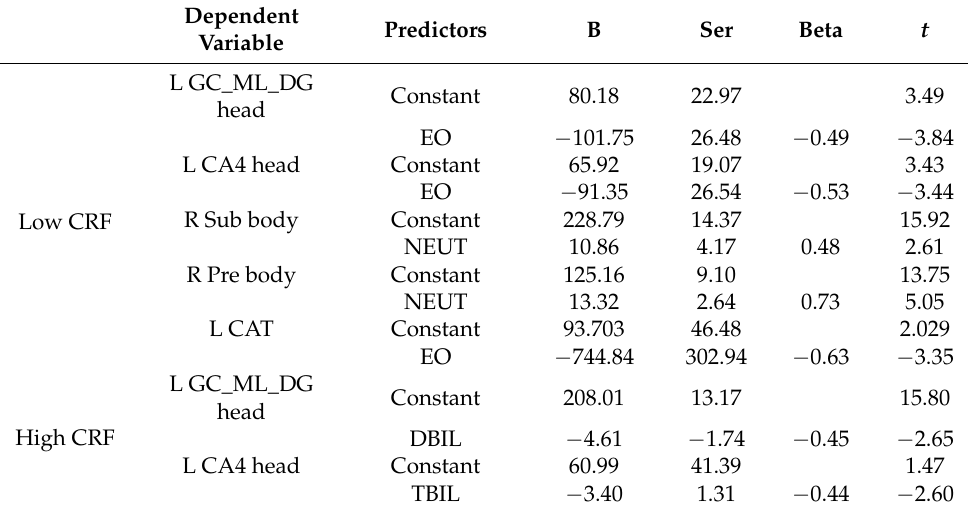
Table 4. Multiple linear regression analysis of the hippocampal subregion, amygdala subregion, and biochemical indexes for both